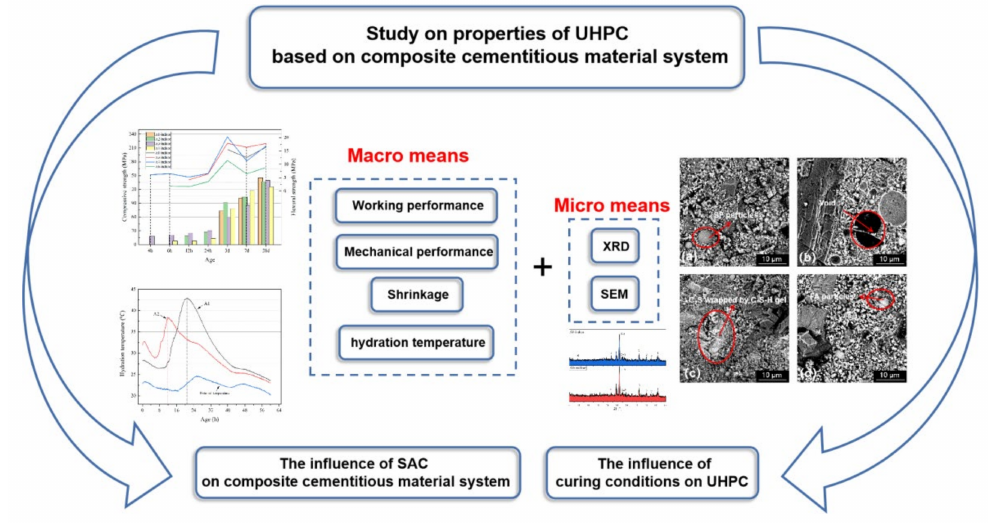
Figure 2. The experiment